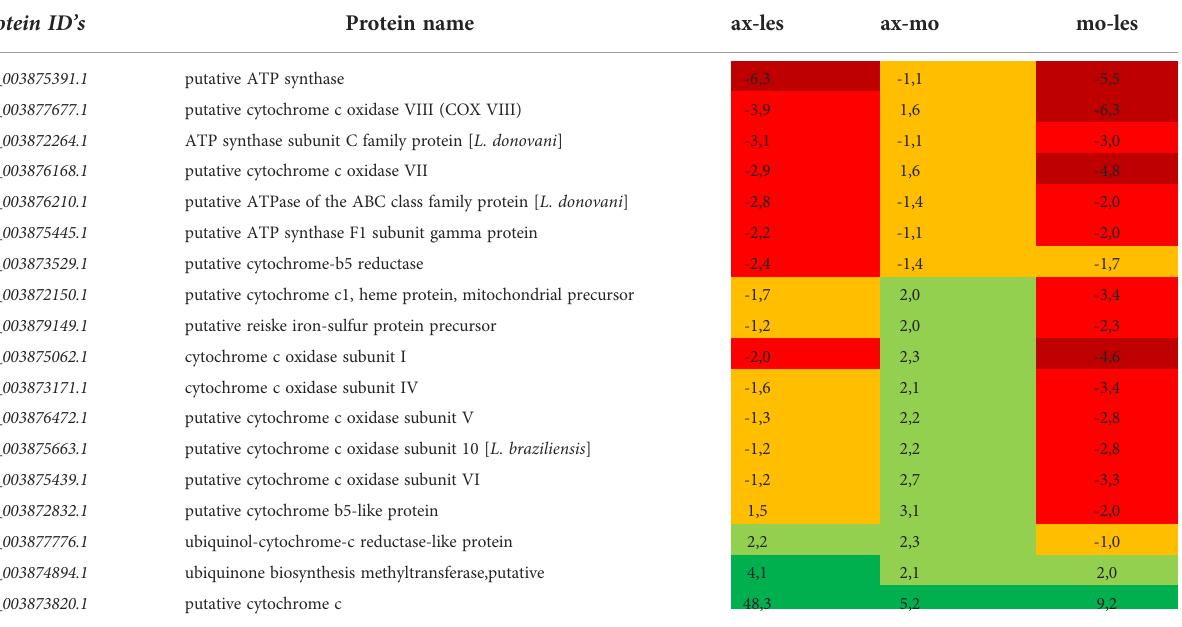
TABLE 4 Proteins of oxidative phosphorylation identi fi ed in all 3 comparisons that differ by at least 2-fold (T-test signi fi cant) between individual amastigote types. Oxidative phosphorylation Protein ID ’